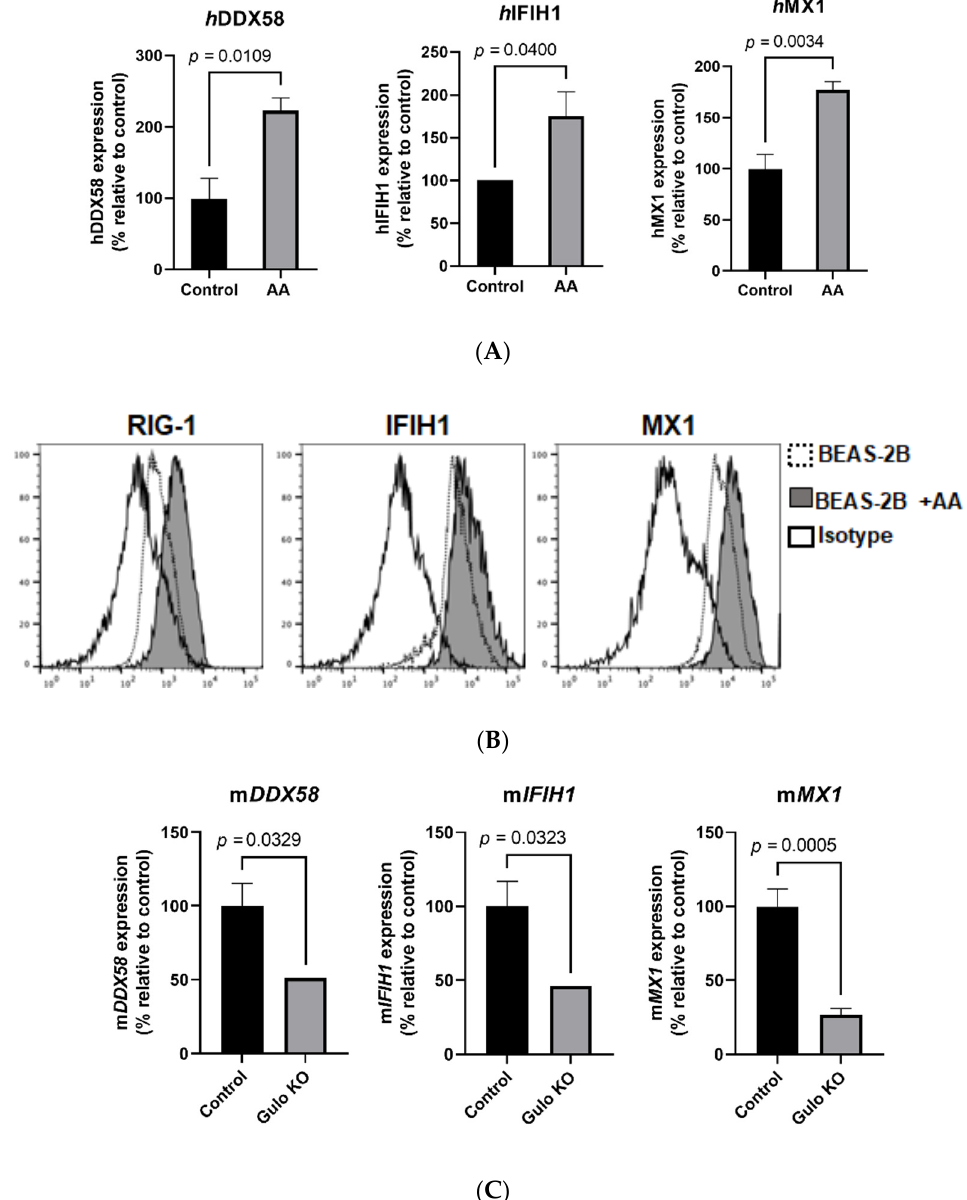
Figure 3. Effect of vitamin C on antiviral gene expression in in vitro and in vivo model systems. RT-qPCR was performed on BEAS-2B cells in the presence and absence of vitamin C/AA. ( A ) Bar graphs depict the expression of RIG-1, IFIH1/MDA-5, and MX1. Data are means ± SE of at least 4 experiments performed on separately isolated samples. ( B ) Histograms depict the expression of these molecules at the protein level using flow cytometry. ( C ) Bar graphs depict the effect of vitamin C deficiency on the expression of murine RIG-1, IFIH1/MDA-5, and MX1 mRNA in the lungs of GULO -KO mice, as determined by RT-qPCR. Data are means ± SE of at least 4–5 sets of mice.